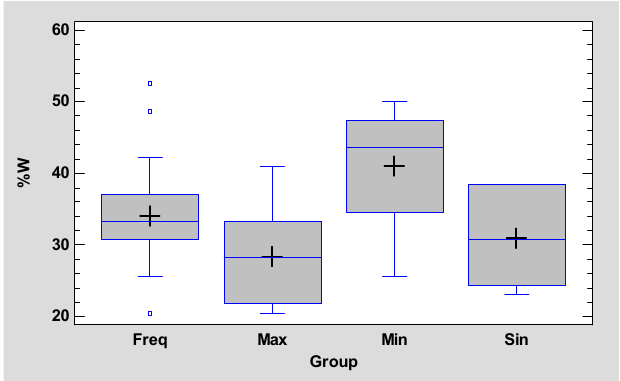
Figure 5. Box chart for %W according to Group.